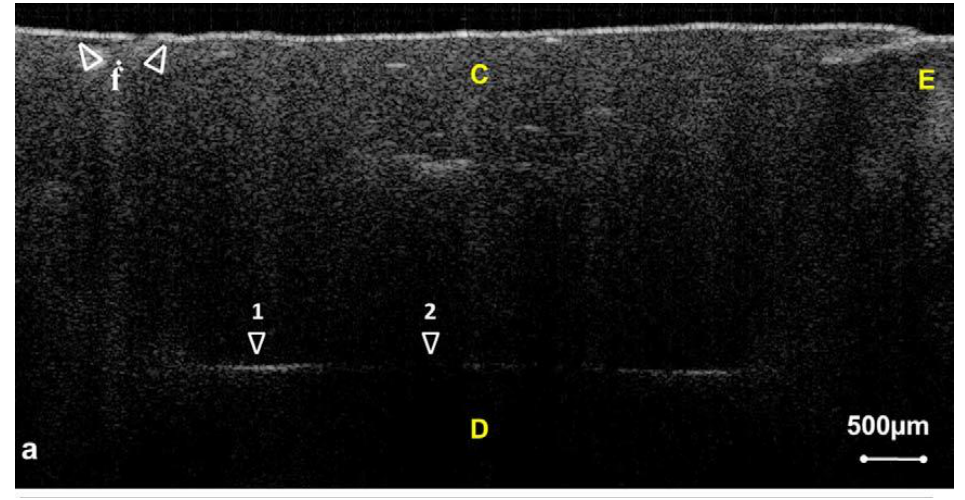
Figure 5. OCT images revealed microleakage between composite resin restoration and the tooth. (C: composite restoration; E: enamel; D: dentin) (reprinted from reference [52]).